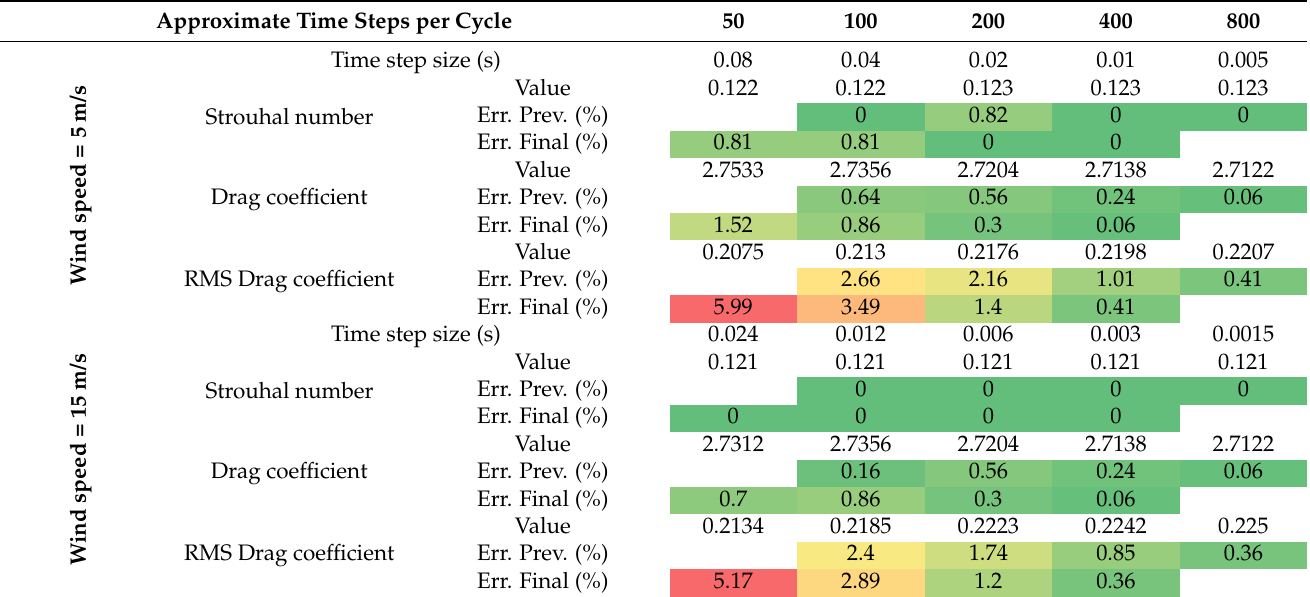
Table 3. Time step test was carried out for two different wind speeds of 5 m/s and 15 m/s. 200 time-steps per cycle was finally chosen. Colors show the error magnitude from low (green) to high (red).